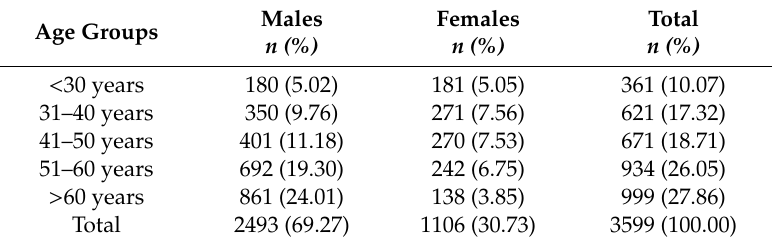
Table 2. Participants’ distribution by age and